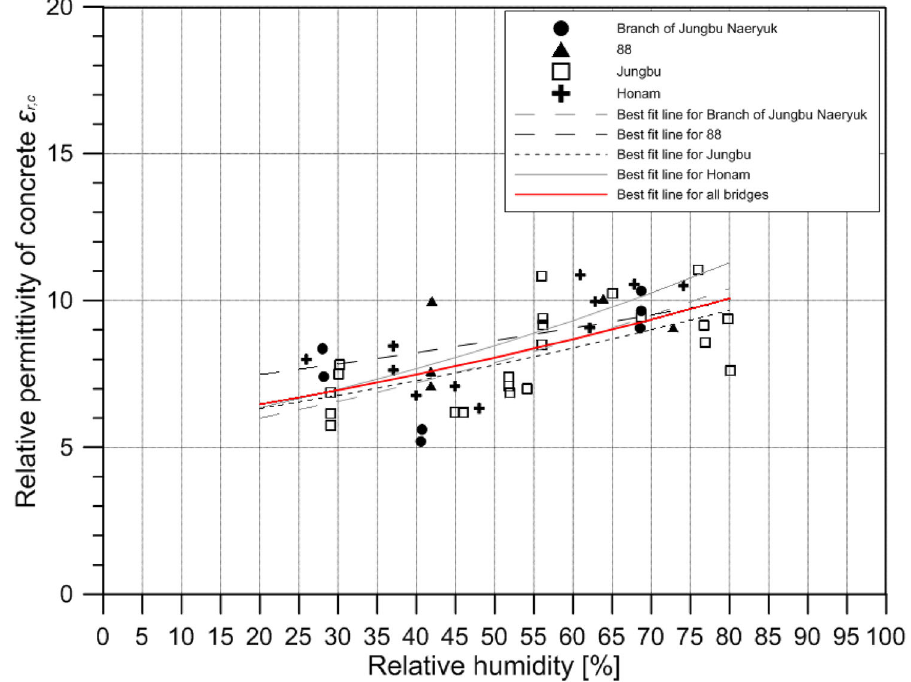
Fig. 7 Variation of relative permittivity of concrete with relative humidity for 4 different old expressway routes.